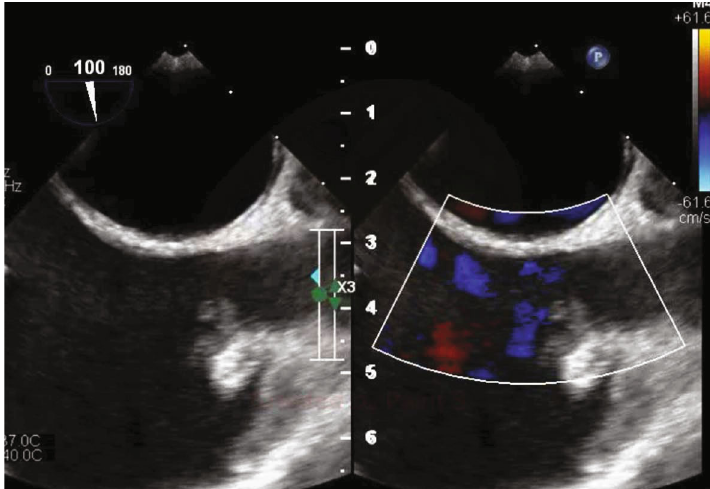
Figure 3: Transesophageal echocardiogram with color Doppler showing mobile thrombus at the junction of the SVC and right